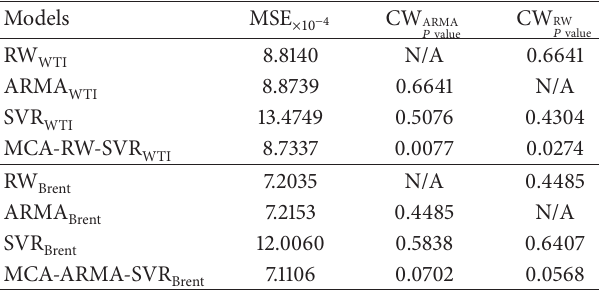
Table 2: Performance comparison of different models.